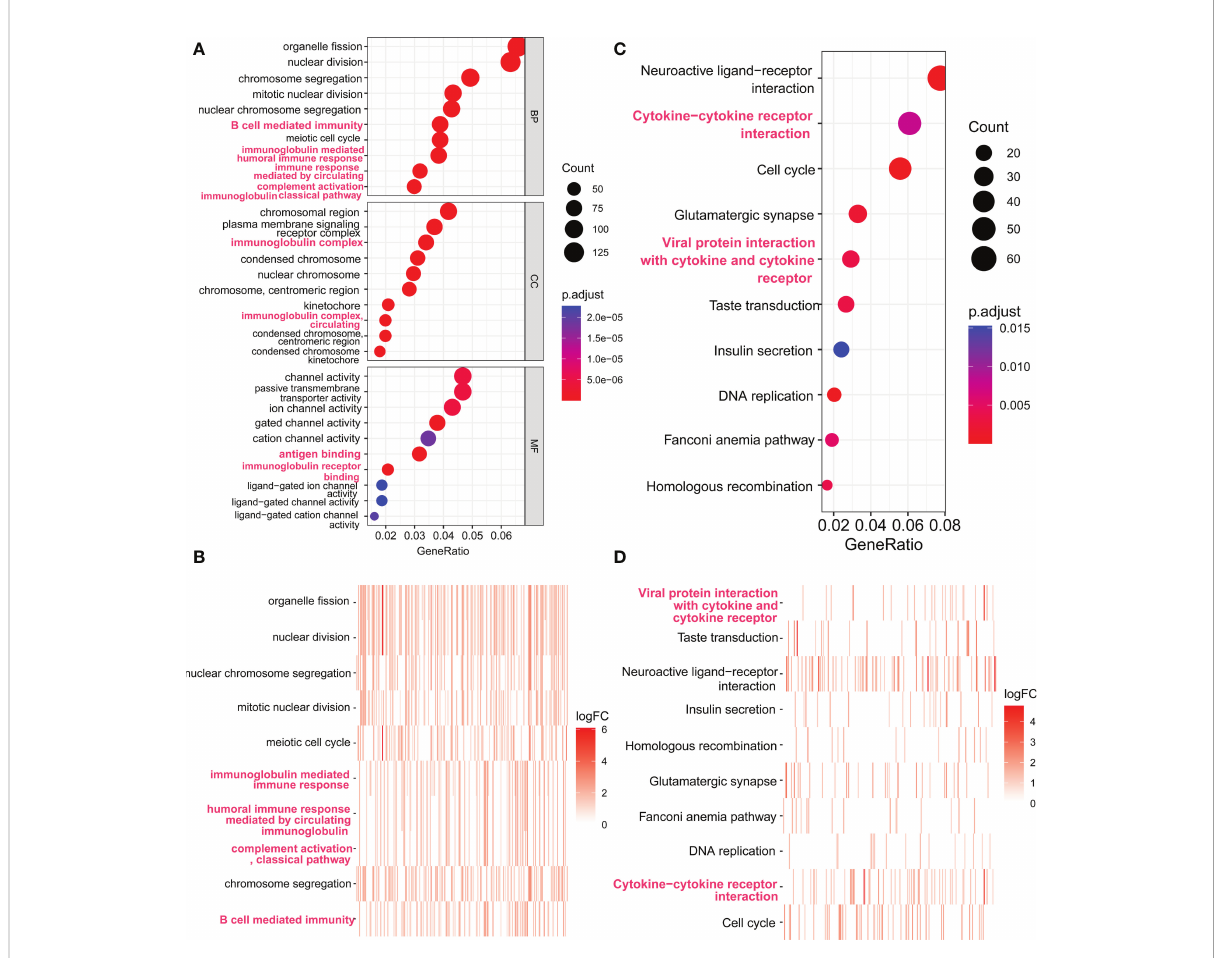
FIGURE 7 Functional enrichment analysis of genes expressed at signi fi cantly higher levels in the high FAM72A expression group. (A, B) Scatter plot and heatmap of the top 10 enriched GO terms sorted by GeneRatio. (C, D) Scatter plot and heatmap of the top 10 enriched KEGG pathways sorted by